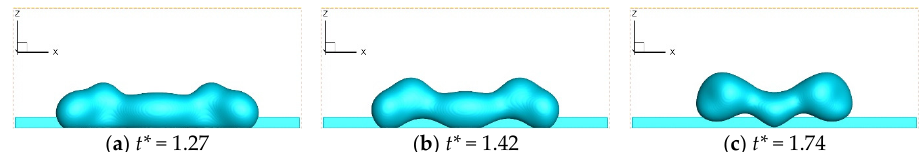
Figure 8. The side view of the coalesced droplet on the S3 surface. ( a – c ) Corresponds to the moments shown in Figure 7f–h.